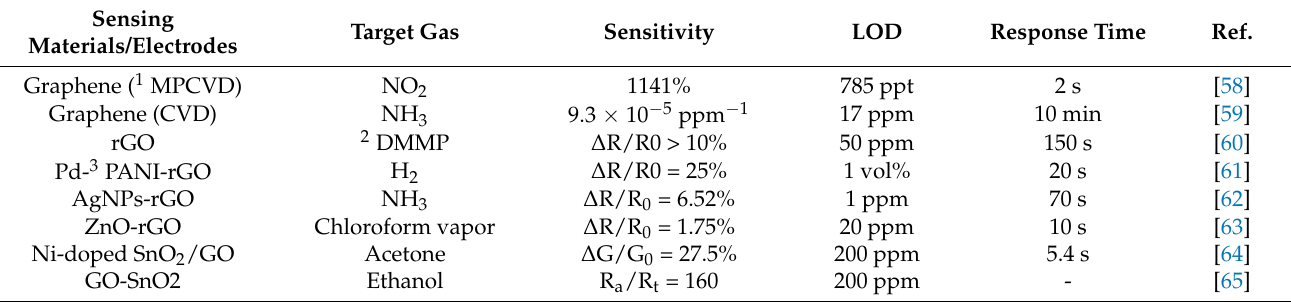
Table 2. Performance between graphene and graphene derivatives in gas sensors.